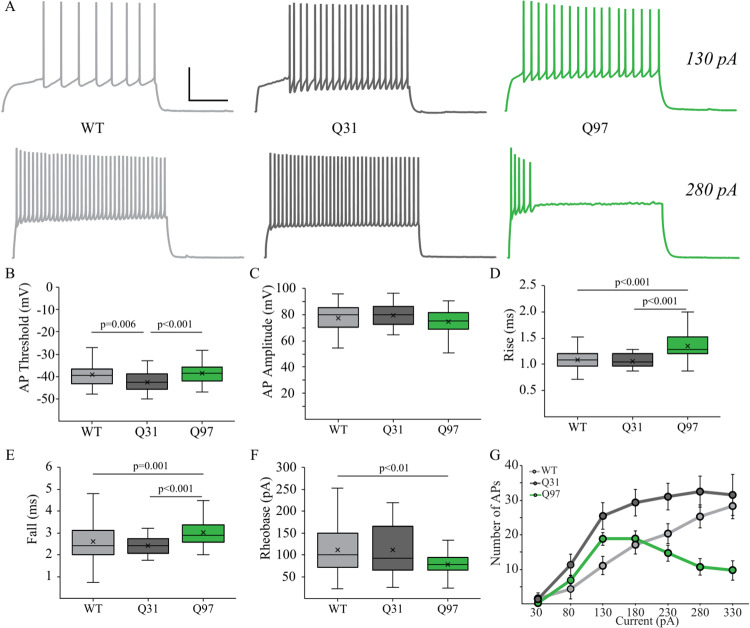
Single and repetitive action potential (AP) properties of MSNs across genotypes.(a) Membrane voltage responses to 2s 130 pA (top) and 280pA (bottom) depolarizing current steps of representative MSNs from WT, Q31 and Q97 mice. Scale bar: 40mV/200ms. (b) AP threshold was significantly lower in Q31 MSNs compared to the other two groups but did not differ between WT and Q97 MSNs (WT, n = 46; Q31, n = 34; Q97, n = 67; Tukey’s test: WT v. Q31, p = 0.006; Q31 v. Q97, p<0.001). (c) AP amplitude did not differ between the three groups (WT, n = 47; Q31, n = 33; Q97, n = 67; ANOVA, p = 0.059). (d, e) the rise and fall times of APs were significantly longer in Q97 MSNs compared to both WT and Q31 MSNs (Rise: WT, n = 44; Q31, n = 33; Q97, n = 65; Kruskal-Wallis test: WT v. Q97, p<0.001; Q31 v. Q97, p<0.001; Fall: WT, n = 45; Q31, n = 31; Q97, n = 63; Kruskal-Wallis test: WT V. Q97, p = 0.001; Q31 v. Q97, p<0.001). (f) Rheobase was significantly lower in Q97 MSNs compared to WT MSNs (WT, n = 48; Q31, n = 33; Q97, n = 63; Tukey’s test: WT v. Q97, p<0.001). (g) Mean f-I curves for MSNs of each genotype. (*WT and Q31, **WT and Q97, and #Q31 and Q97; 130 pA, *p<0.01; 180 pA, *p = 0.01, #p<0.05; 230 pA, *p<0.05, #p<0.001; 280 pA, **p<0.01, #p,0.001; 330 pA, **p<0.01, #p<0.01; p-values from posthoc Tukey tests).